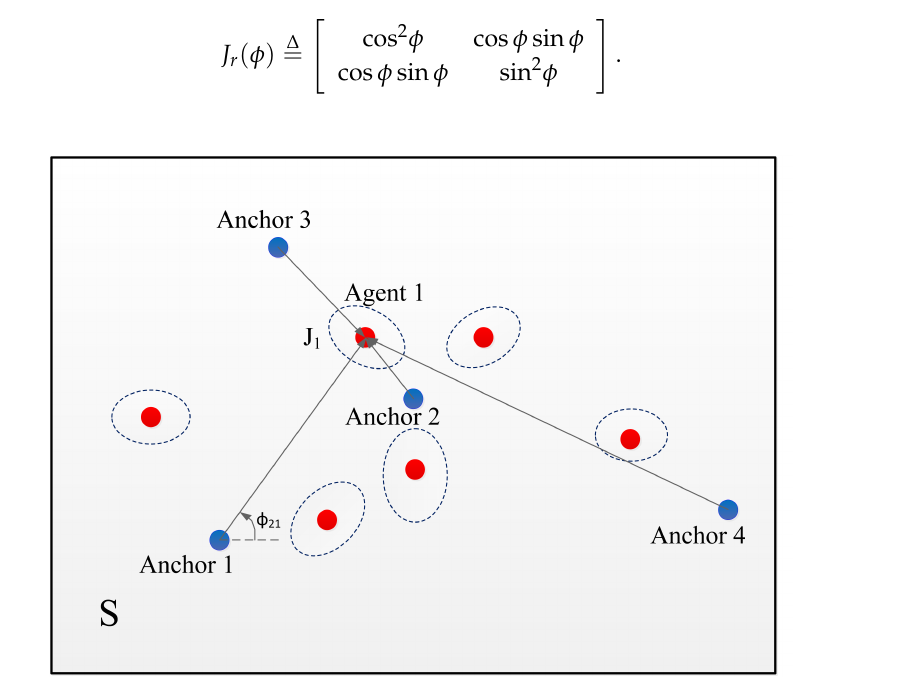
Figure 1. Illustration of a N b = 4 WSN localization system: anchor nodes (blue dots) communicate with agent nodes (red dots). Only the connecting relationship between Agent 1 and anchor nodes is shown. The dashed ellipses represent the location information of each agent